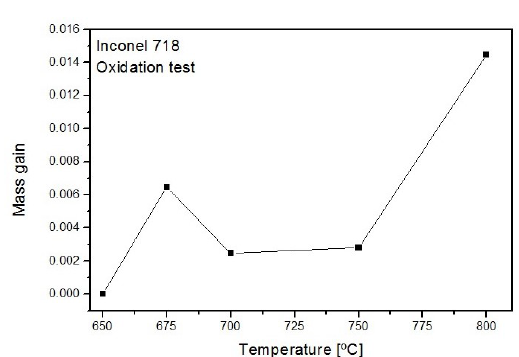
Figure 3. Dependence of mass gain with temperature oxidation test in Inconel 718 alloy.